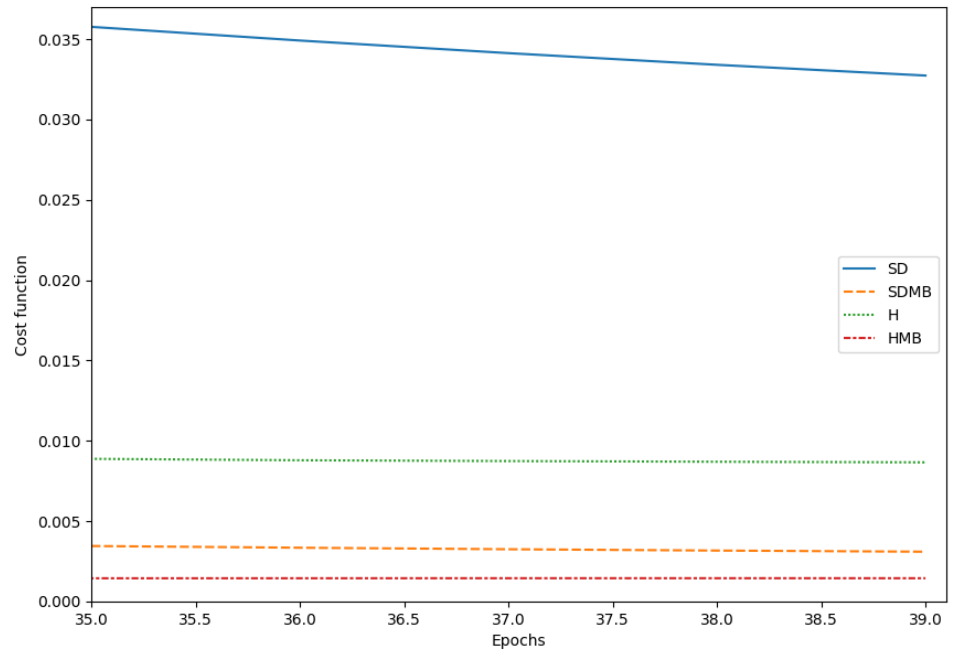
Figure 3. A zoom of the cost maps after 40 epochs during training.